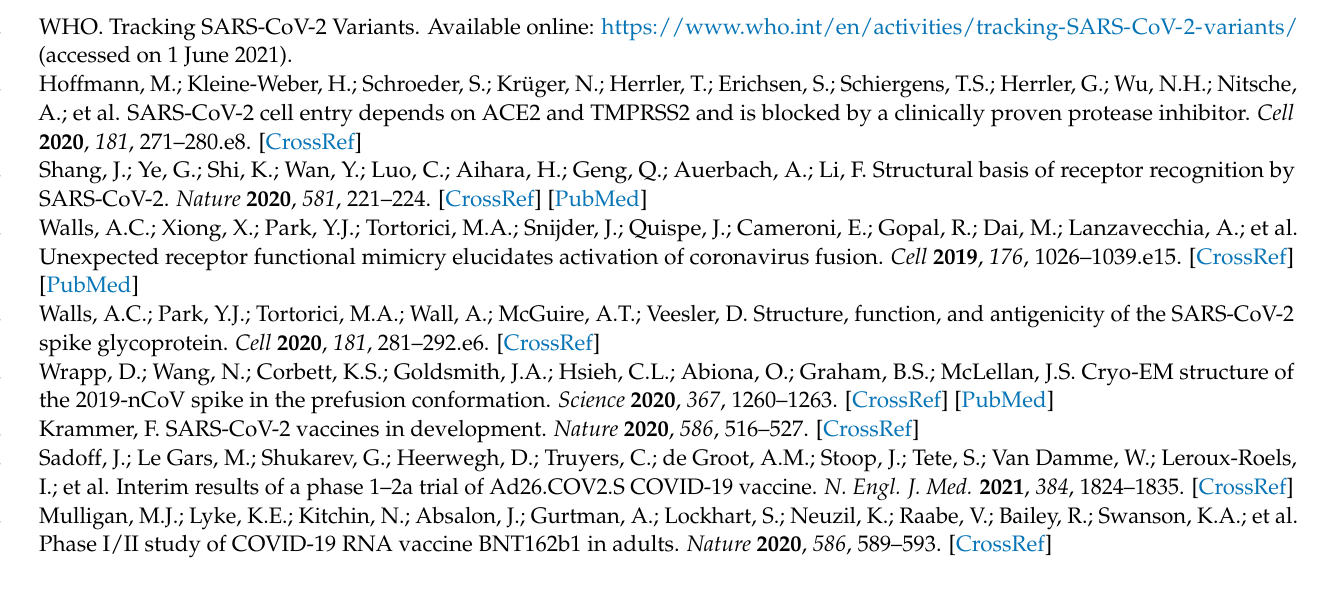
Table S1: Binding Kinetics of the interaction between SARS-CoV-2 RBD and sACE2 quantified by Biolayer Interferometry; Table S2: Summary of ACE2 Binding, plasma binding, and neutralization to